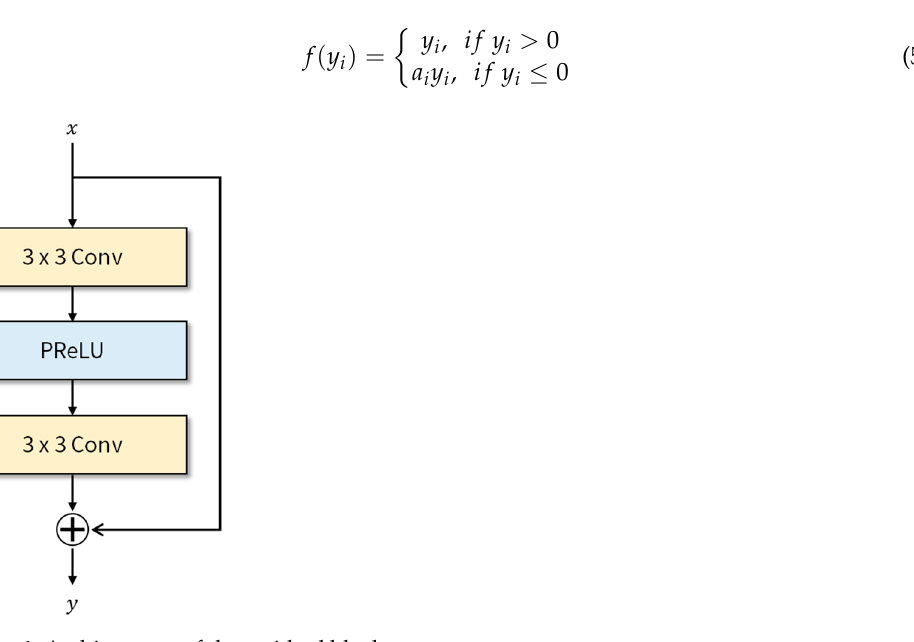
Figure 4. Architectures of the residual block.